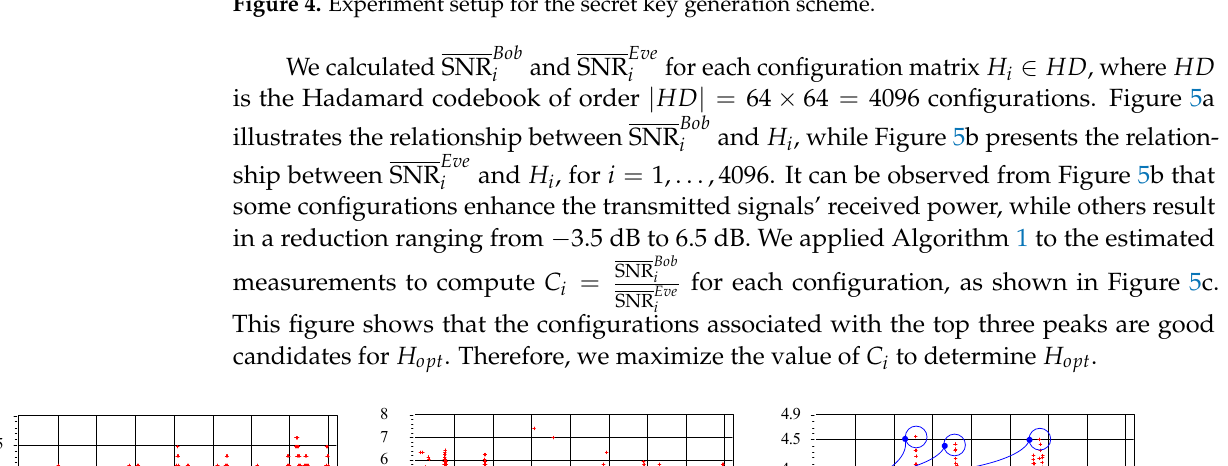
Figure 4. Experiment setup for the secret key generation scheme.